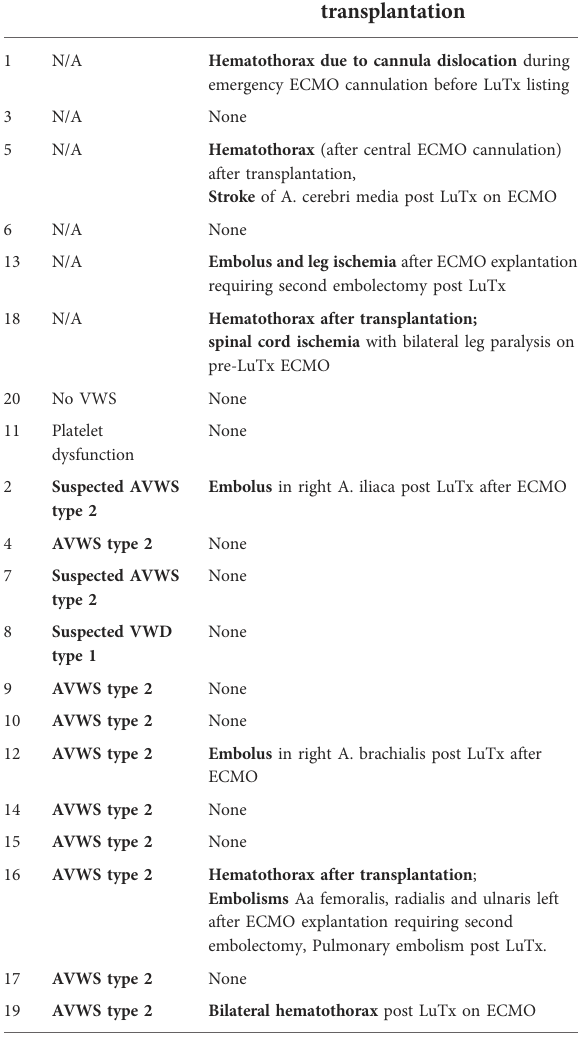
TABLE 3 Diagnosis and hemostaseologic complications peri- translantation.